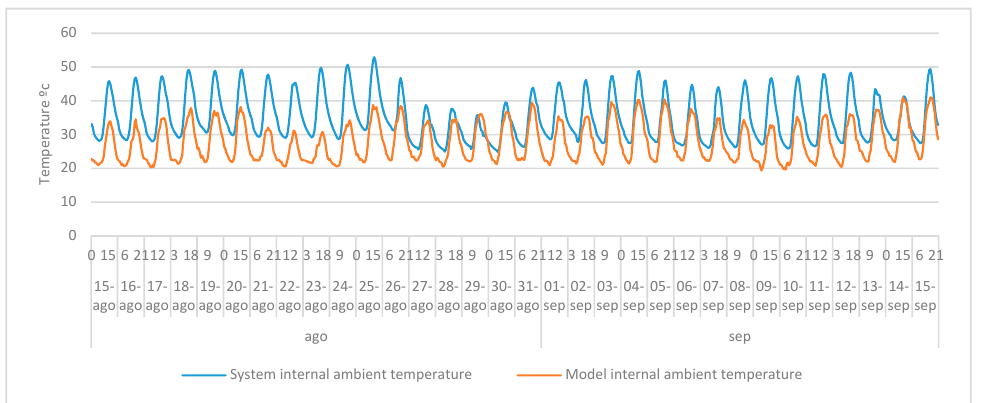
Figure 10. Internal (ambient) temperature for the building.